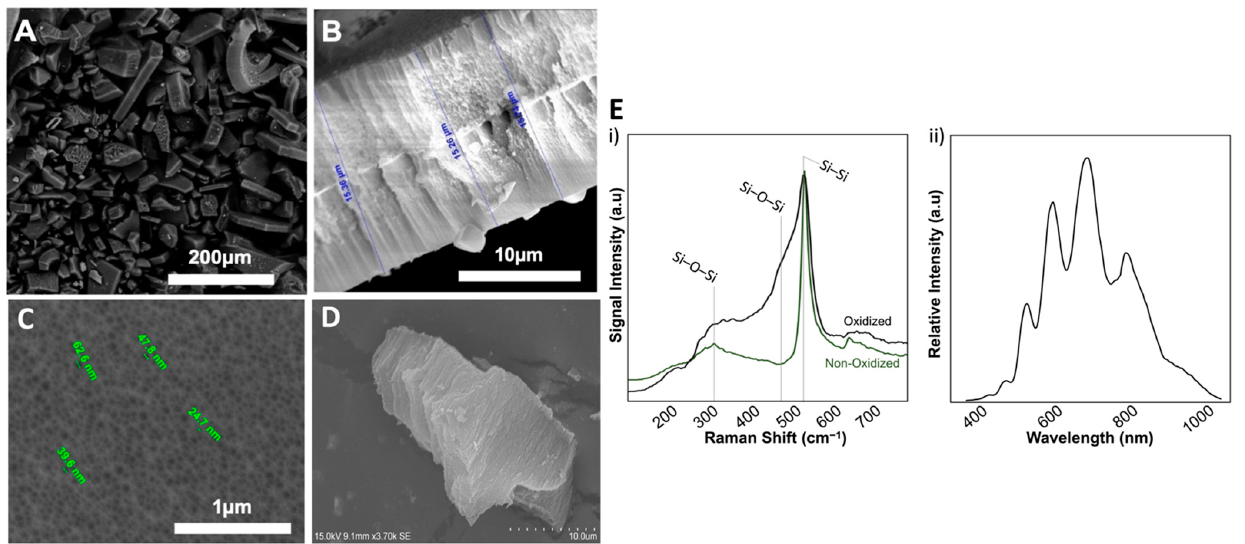
Figure 2. ( Left panel) SEM images of pSi-TC particles ( A ) showing a cubic shape (×130), ( B ) side view, showing porous structure (×10,000). ( C ) top view, revealing the homogeneous porous structure; magnification ×100,000 ( D ) cross-section view of Cubic shaped pSi-TC nanoparticles. ( Right panel, E ): (i) Raman spectra acquired before and after oxidation of pSi samples (non-oxidized and oxidized, respectively). Oxidation is indicated by the appearance of Si-O-Si peaks (ii) IRS of pSi samples (before particle formation by sonication).